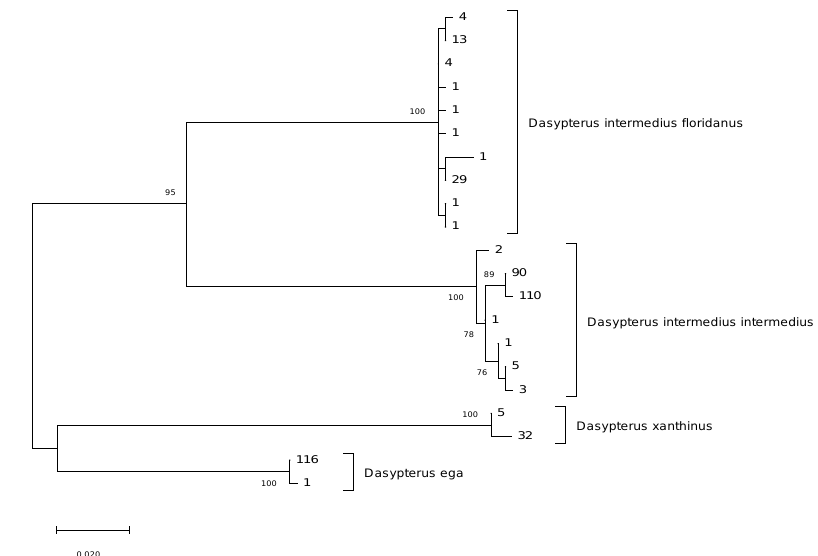
Figure 2. Maximum likelihood tree of unique cytochrome c oxidase I (COI) haplotypes from Dasypterus samples in this study, as well as samples obtained from Korstian et al. [17] and from GenBank. Numbers at the nodes indicate bootstrap support following 1000 replicates, and branch length represents genetic distance. Numbers at branch tips represent the number of individuals with that unique haplotype.